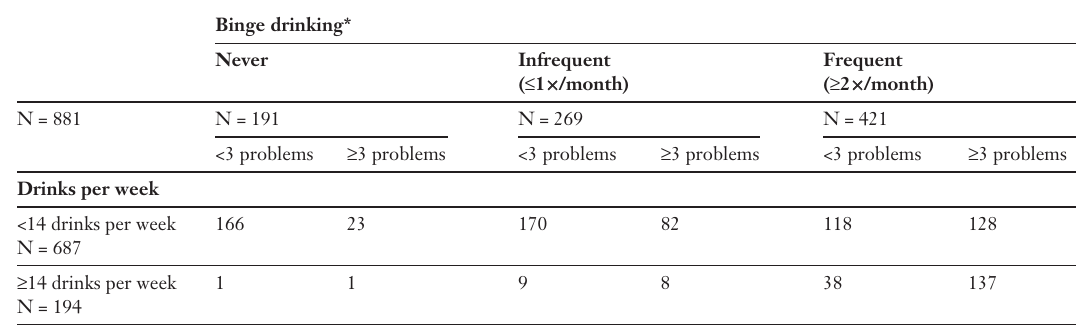
quences according to average weekly alcohol use and binge drinking